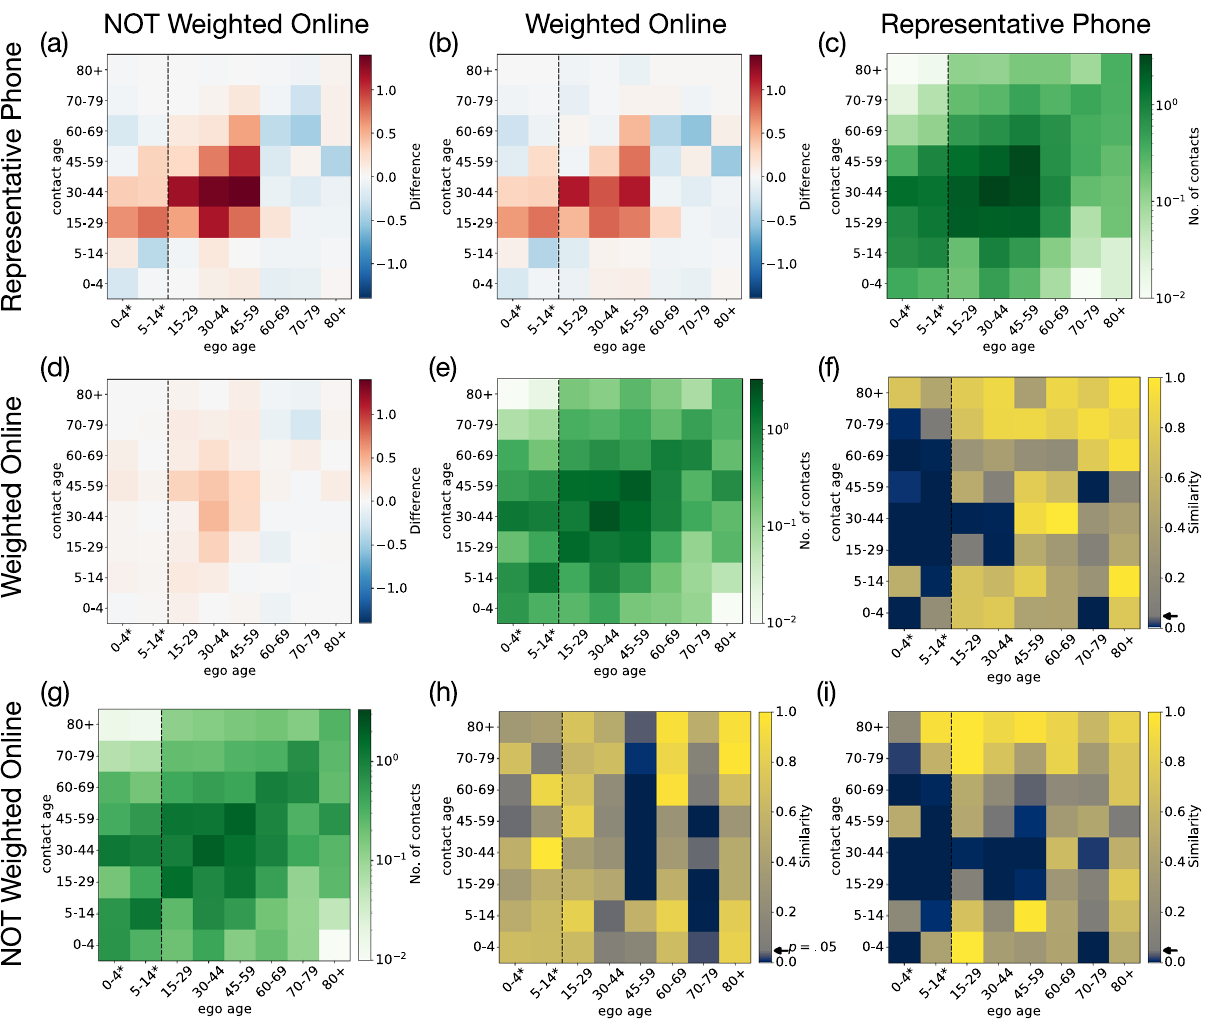
Figure 3. Results of iterative proportional fitting. Normalized actual proxy contact matrices (green diagonal), their pairwise difference matrices (above diagonal) and pairwise two-tail T-test results (below diagonal) are depicted for the online non-weighted, online weighted, and representative matrices. In the difference matrices red or blue cells indicate that the source matrix (column label) appeared with higher or lower number (respectively) of average contacts compared to the target (row label) in a given cell. For results of pairwise two- tail T-tests blue to yellow cells (corresponding to p > 0.05 , assigned by an arrow beside the colorbar) indicate that the given cell is not significantly different in the source (column label) and target (row label) matrices. Data for children under 18 (indicated with asterisk and vertical dashed lines) could not be collected directly due to privacy regulations, thus our data cannot provide a representative sample for the first two age groups (see